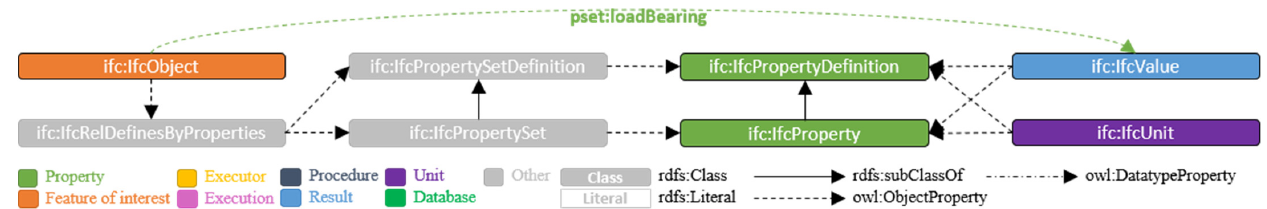
Figure 1. ifcOWL’s design pattern linking properties to property sets.